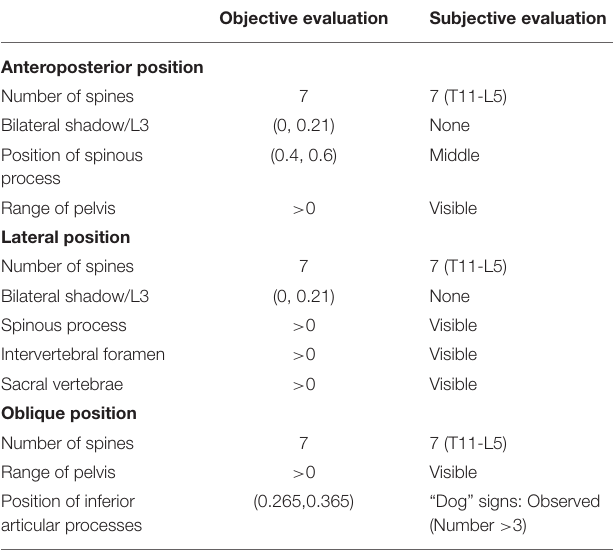
TABLE 1 | Criterion of objective and subjective